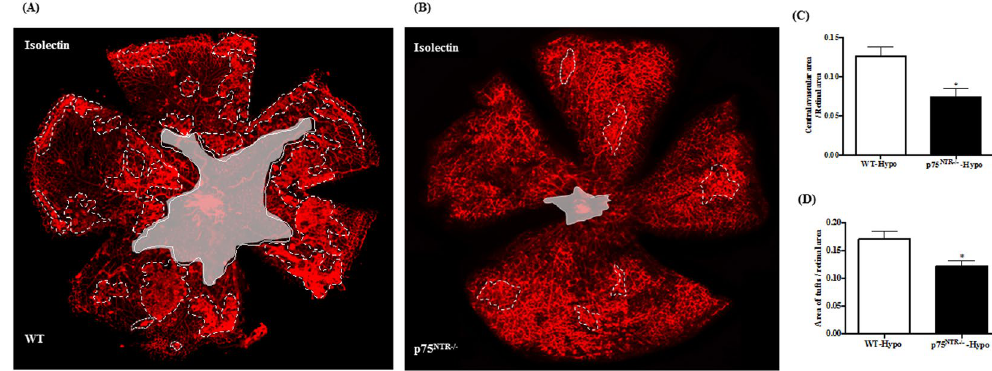
Figure 5. Deletion of p75 NTR attenuated hypoxia-induced neovascularization and enhances reparative angiogenesis. ( A , B ) Representative images of GS-isolectin stained retinal flat mounts of WT and p75 NTR − / − pups at p17, showing pathological retinal neovascularization (RNV, encircled by dotted white line) and central avascular area (encircled area at the center). Images were taken on 5X magnification. Bar graph of RNV ( C ) and central avascular area ( D ) showing significant decrease in both manifestations in p75 NTR − / − pups by p14 during hypoxic stage of OIR ( * significant using unpaired student T-test, p < 0.05, n = 7–14). Hypo: relative hypoxia- exposed groups, RNV: retinal neovascularization.